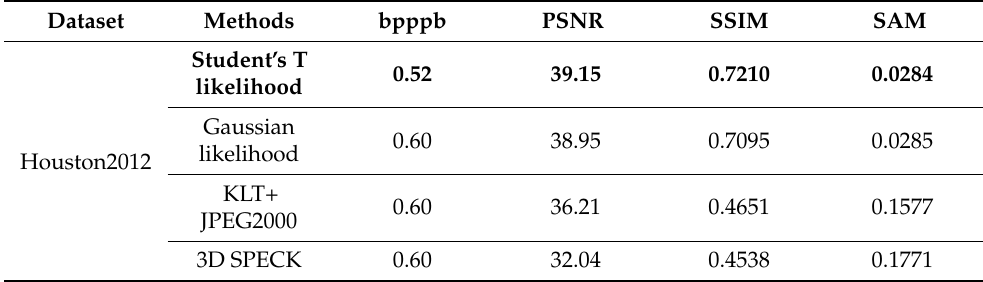
Table A3. Rate-distortion performance for relatively low bit rates; the comparatively ideal choice is marked in bold ( λ = 0.000005